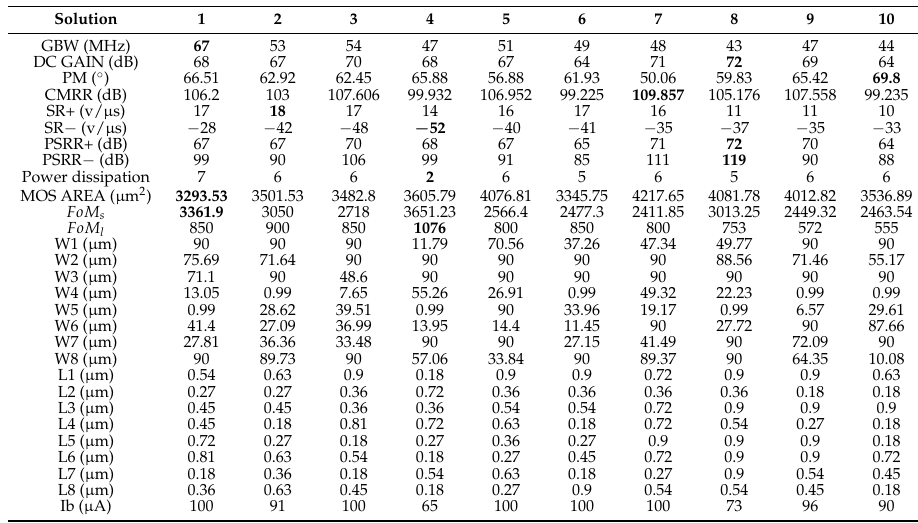
Table 4. Electrical characteristics and feasible W/L sizes of the RFC-OTA guaranteeing DCOP conditions of the MOS transistors applying PSO for the best 10 runs. The best values are highlighted in bold face.